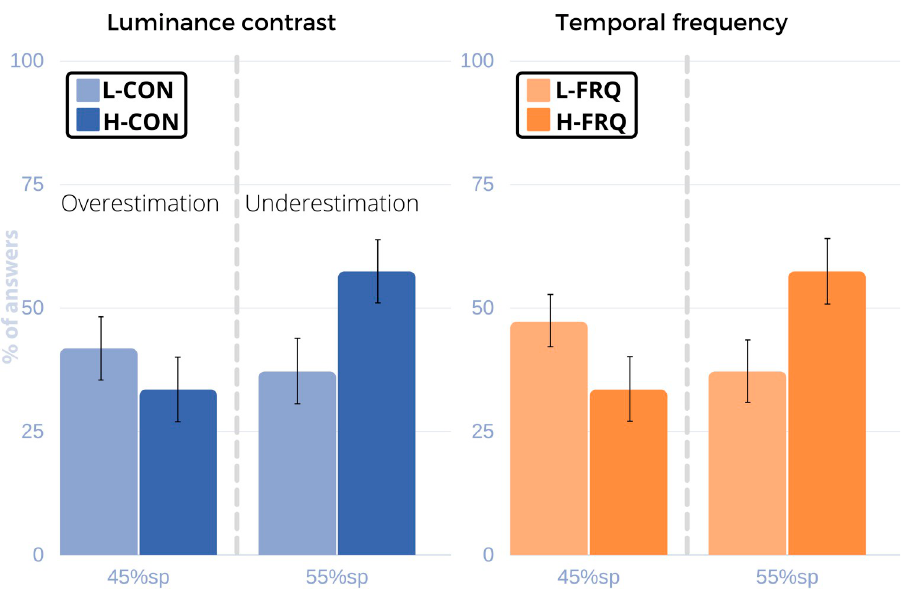
Fig 4. Results for the follow-up replication study with conventional displays. Left: Luminance contrast trials. Right: Temporal frequency trials. Y axis: % of answers. X axis: 45% and 55% sampling points (sp). The displayed bars of each graph correspond to p over,45 at the 45% sp (overestimation) and to p under,55 at the 55% sp (underestimation). The percentage of correct answers for each case is complementary to the displayed value in the graph (p corr,45 +p over,45 = 100% and p corr,55 +p under,55 = 100%). Like in Experiment 1, overestimation is always more frequent in low magnitude levels and underestimation in high magnitude levels, regardless of the visual feature.